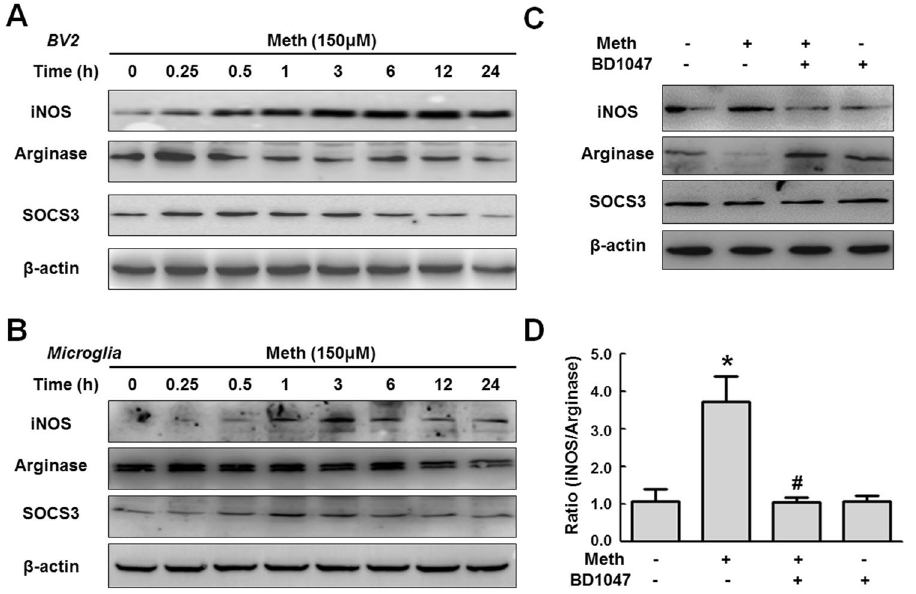
Figure 1. A correct version of the original Figure